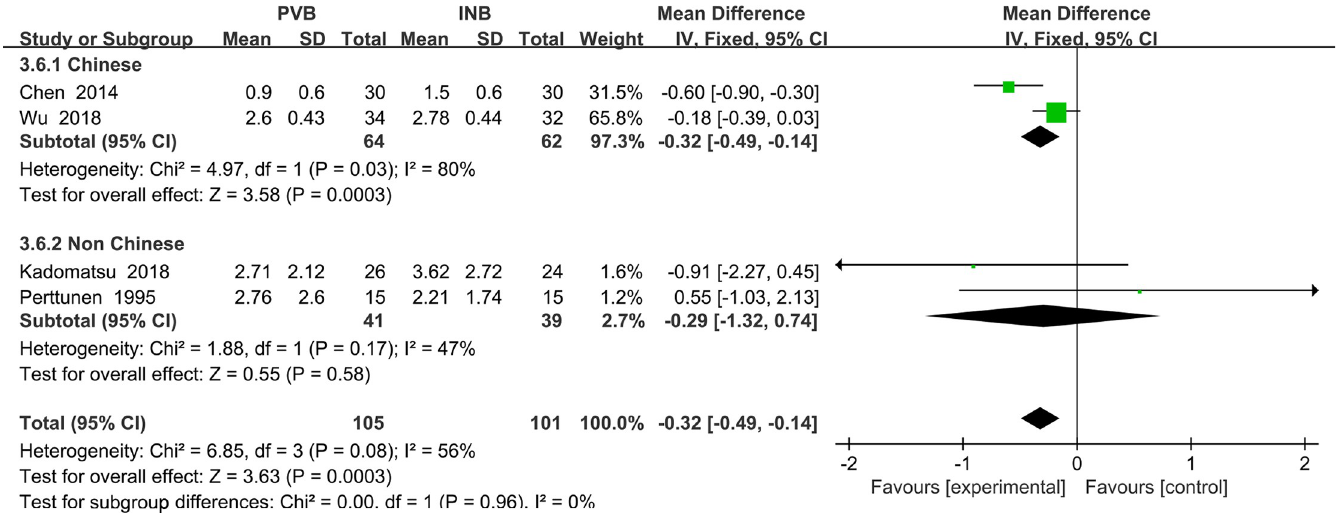
Fig 12. Subgroup analysis of comparison: Chinese VS non Chinese. Outcome: VAS at rest at the first 24 h.